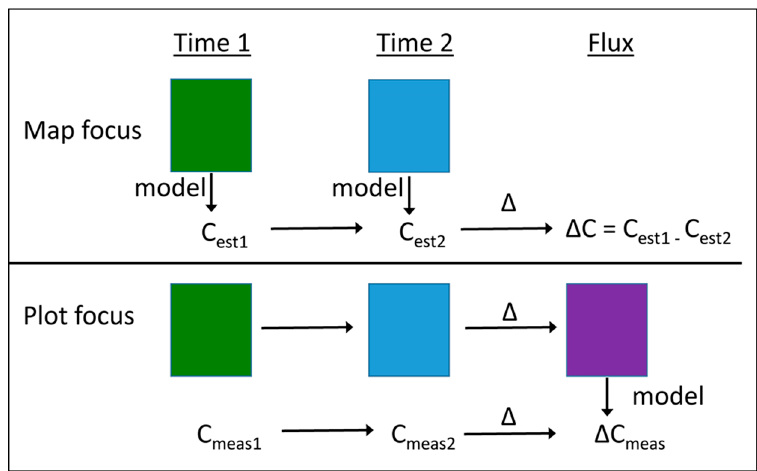
Figure 1. Conceptual diagram comparing applications of remote sensing to estimate carbon (C). In the map approach, C at each time step is modeled from spectral signatures, with C flux equal to the change in estimated C. In the plot approach, measured C flux is modeled directly from spectral change, which can then be applied to other plot measurements (e.g., to estimate C at time 2 when it has not been remeasured yet).